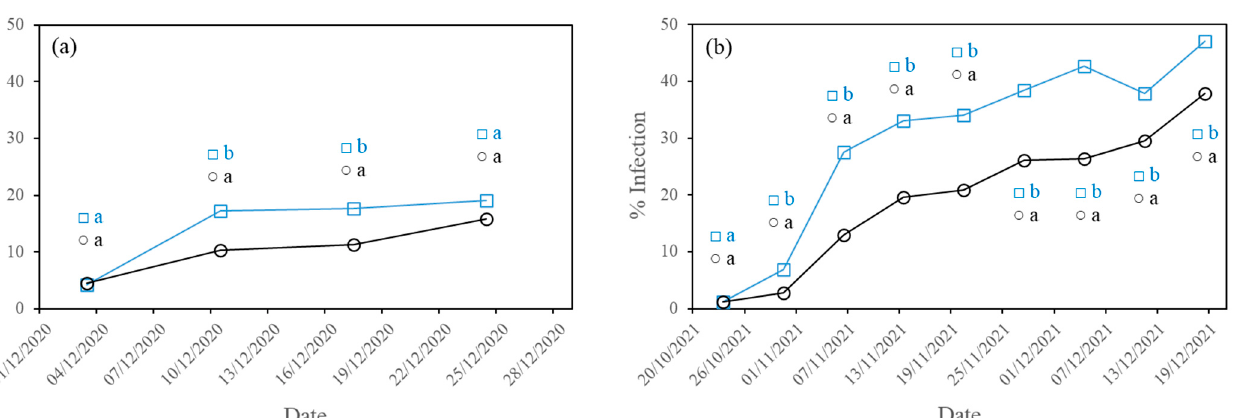
Figure 3. Development of powdery mildew ( S. fuliginea ) percentage of infection over time, for the first crop cycle ( a ) and for the second crop cycle ( b ). Sector with commercial film C F ( □ ); Sector with experimental film E F ( ○ ). Different letters indicate statistically significant difference ( p -value ≤ 0.95).